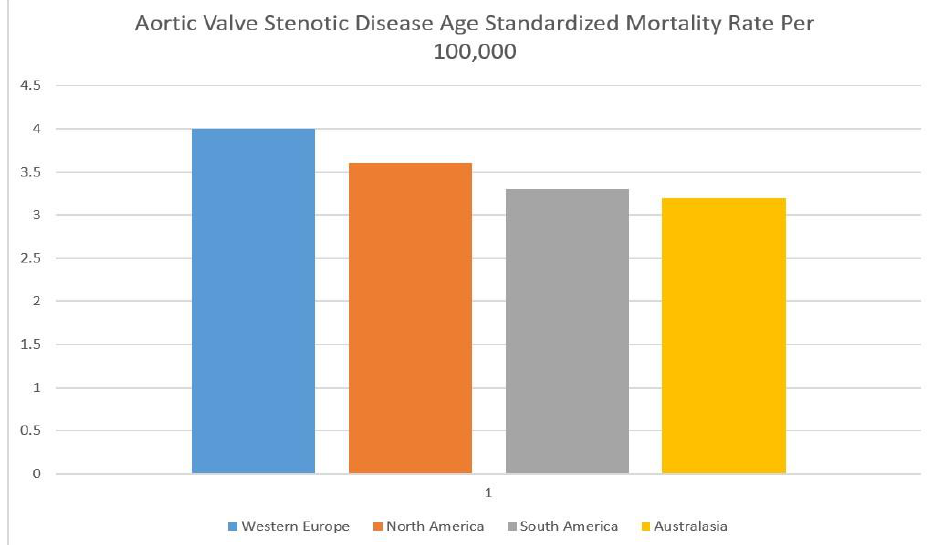
Figure 2. Bar chart showing aortic valve stenotic disease age-standardized mortality rate per 100,000.